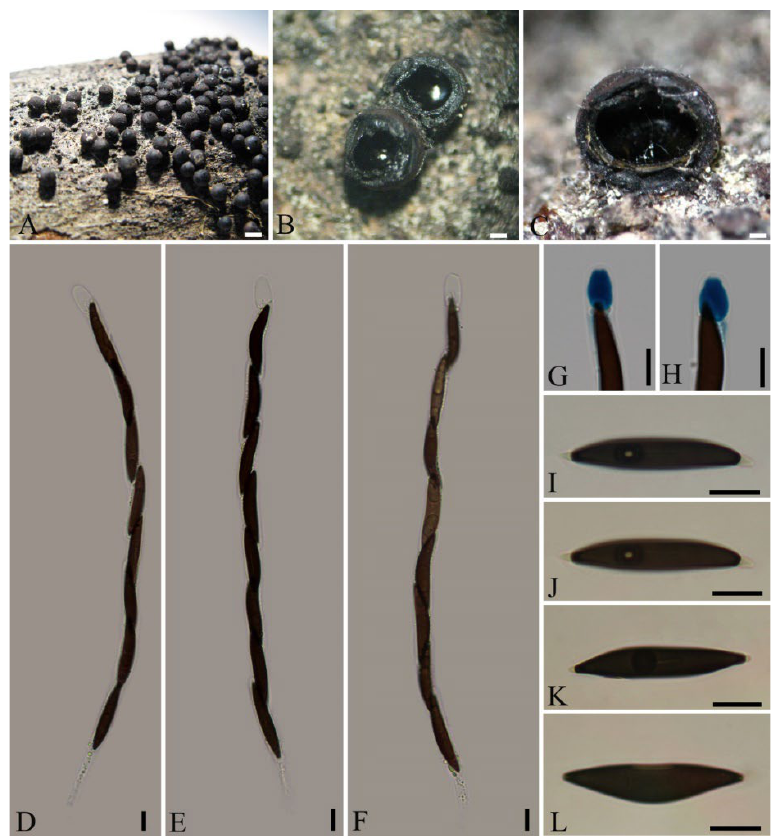
Figure 4. Dematophora populi (GZUH0116) ( A – C ) Stromata on the host; ( D – F ) Asci.; ( G , H ) Urn-shaped J+ apical rings (stained in Melzer’s reagent); ( I – L ) Ascospores with short cell appendage on the ends. Bars: ( A ) = 1000 µ m, ( B ) = 500 µ m, ( C ) = 200 µ m, ( D – L ) = 10 µ